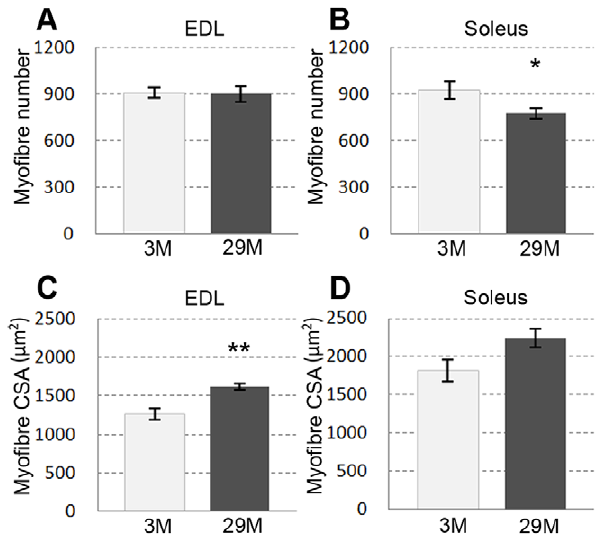
Figure 5. Total myofibre number (A,B) and average myofibre cross-sectional area (CSA) (C,D) in EDL and soleus muscles. At 29 months, there was no significant loss of myofibres in the EDL (A), but a significant loss in the soleus (B). The average myofibre CSA was larger in 29 month old compared to 3 month old EDLs (C); whereas the average myofibre CSA was similar in soleus muscles at 3 and 29 months (D). N=4 mice per age group. *P , 0.05, **P , 0.005. Values are mean 6